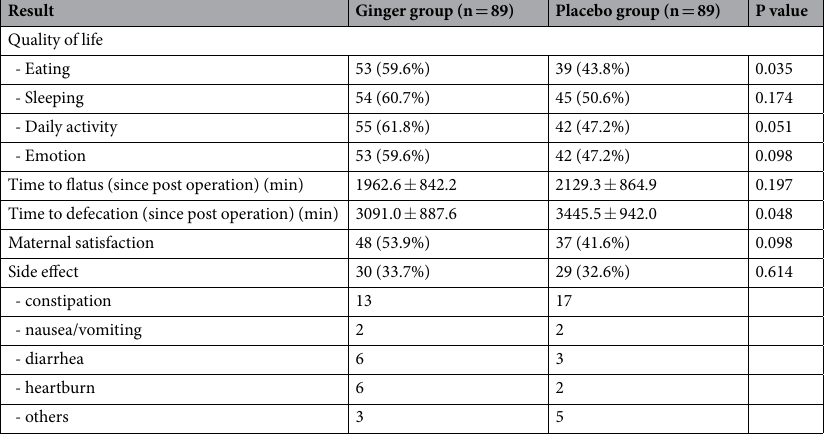
Time to defecation (since post operation) (min) 3091.0 ± 887.6